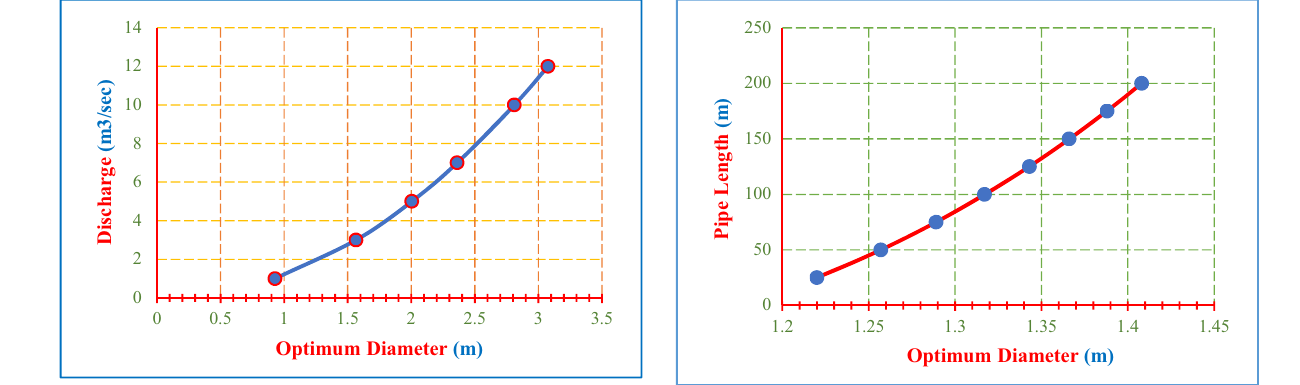
Figure 3: Optimum diameter vs discharge.